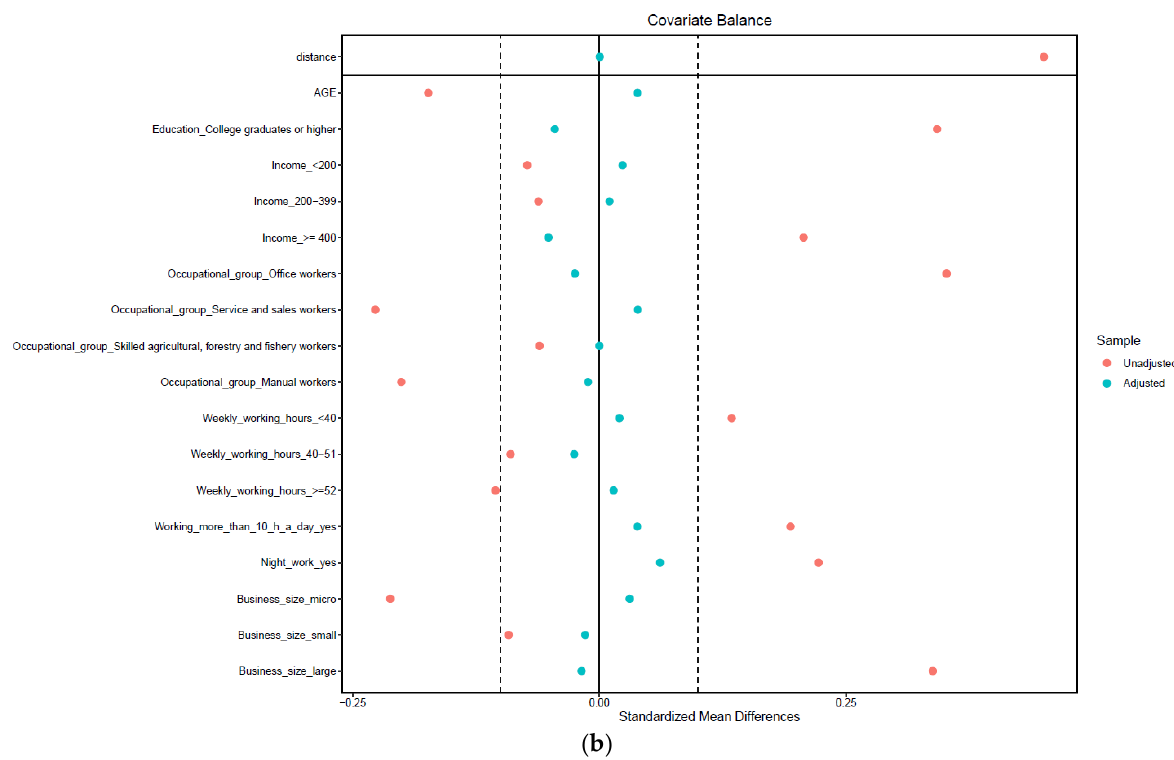
Figure 2. Standardized mean differences in covariates used in propensity score matching. ( a ) Male workers. ( b ) Female workers. Table 2. Characteristics of male and female participants by telework after propensity score match- ing.